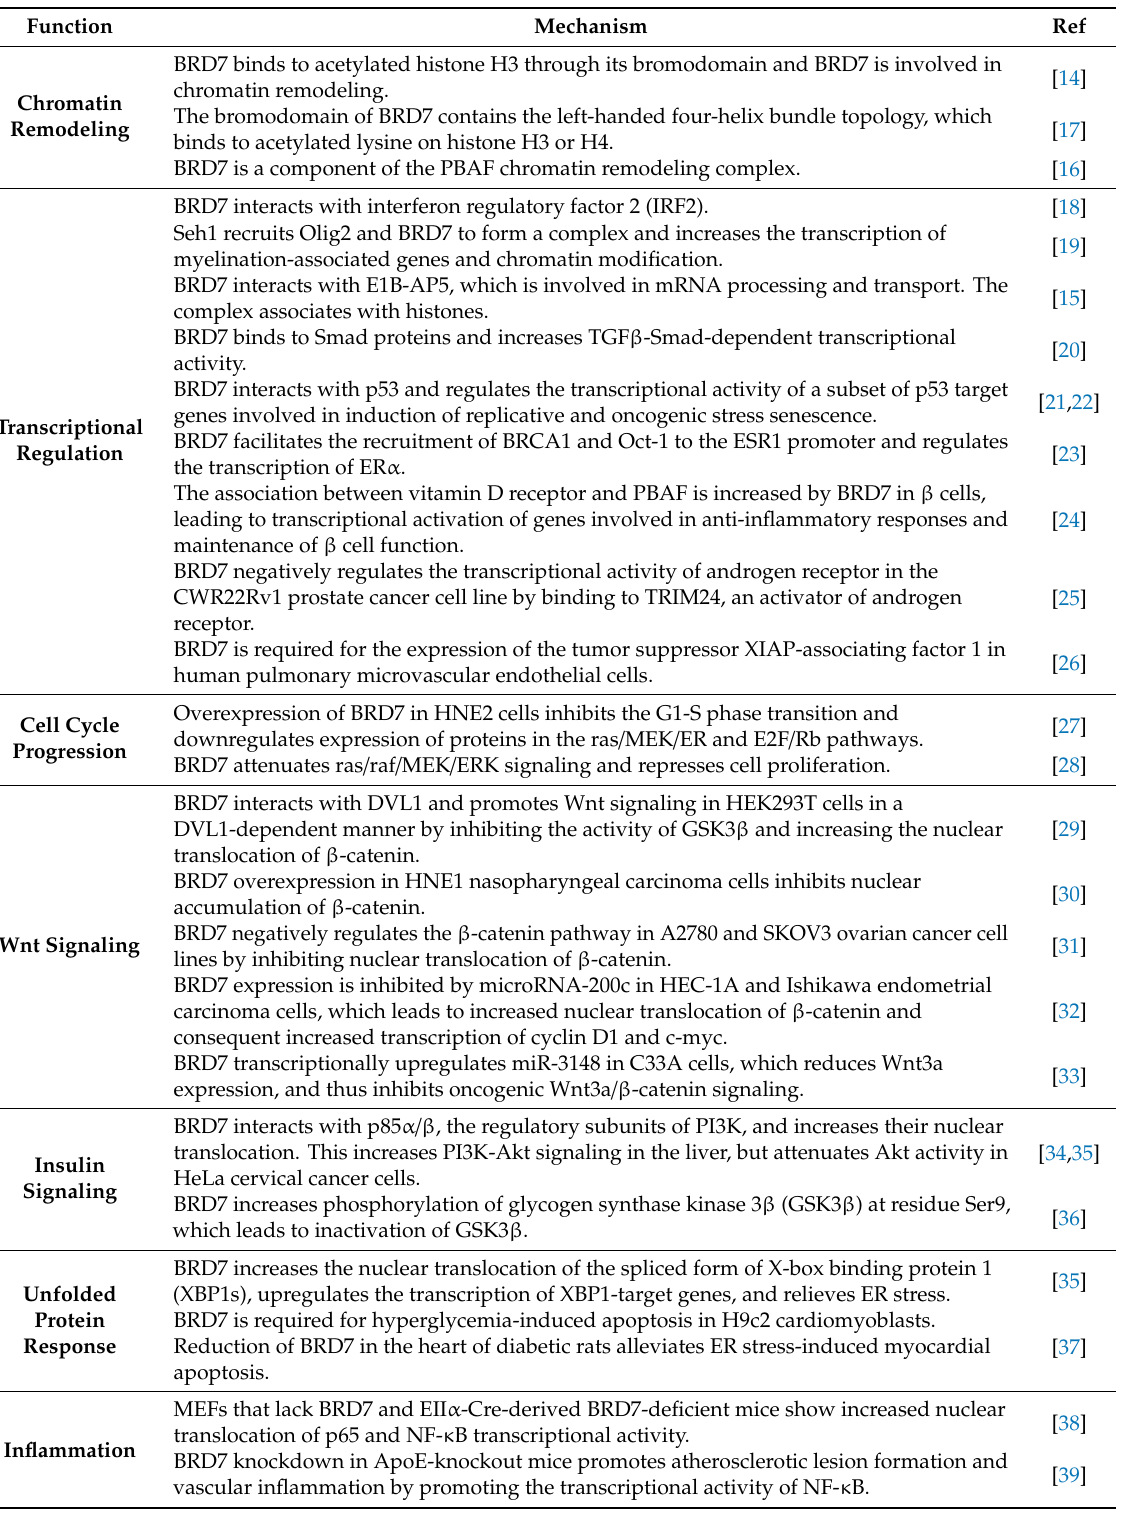
Table 1. BRD7’s function. The role of BRD7 is summarized by cellular function. Function Mechanism Ref